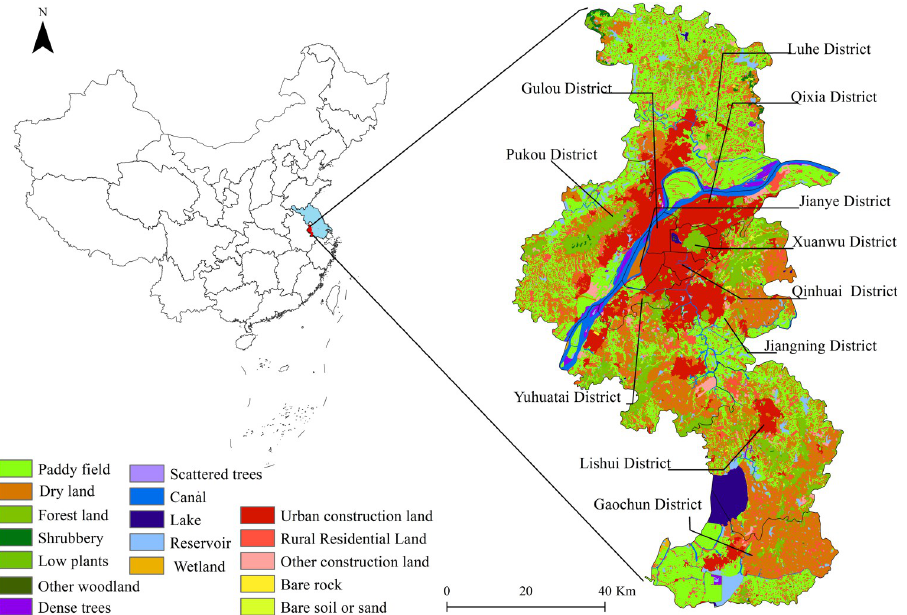
Fig 1. Location of the study area. The location of Nanjing in China and Jiangsu. examined in this paper, in Jiangsu Province (blue), in Nanjing City (red), and on the right side is the District of Nanjing city. This map is drawn by the authors. This map was created using ArcGIS 1 software by Esri, © National Platform for Common Geospatial Information Services, © USGS, © Resource and Environment Science and Data Center, © Baidu, © OpenStreetMap and contributors, Creative Commons Attribution 4.0(CC BY 4.0).